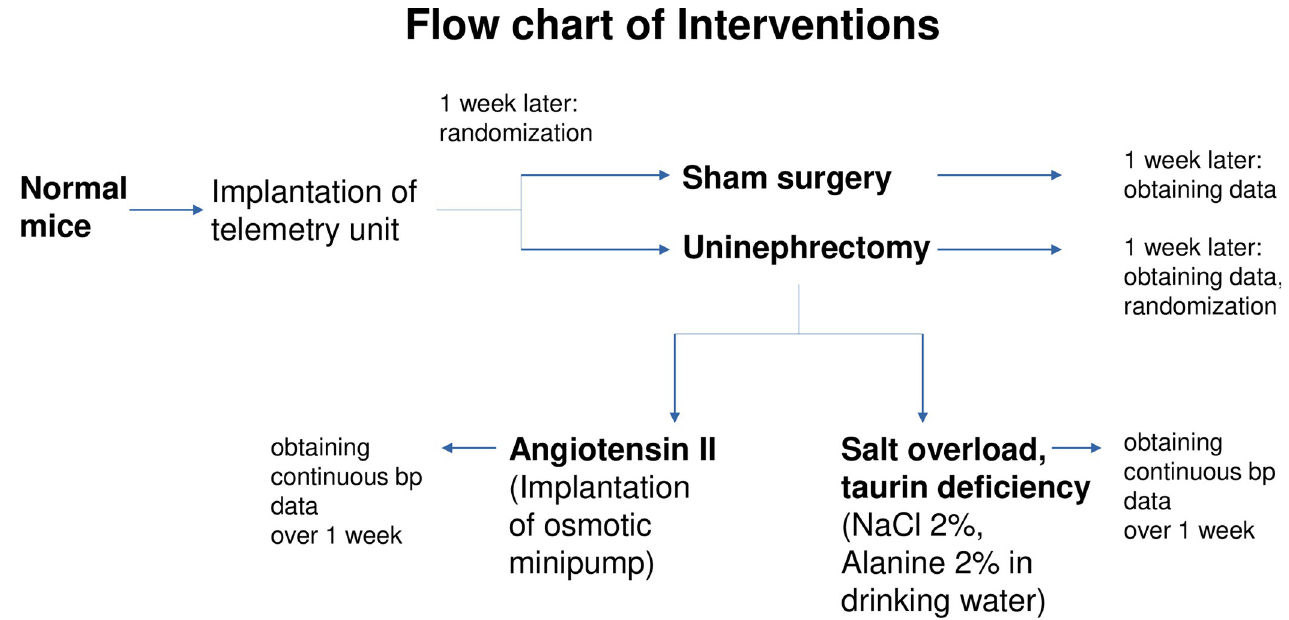
Fig 1. Experimental setting of murine models uninephrectomy and secondary arterial